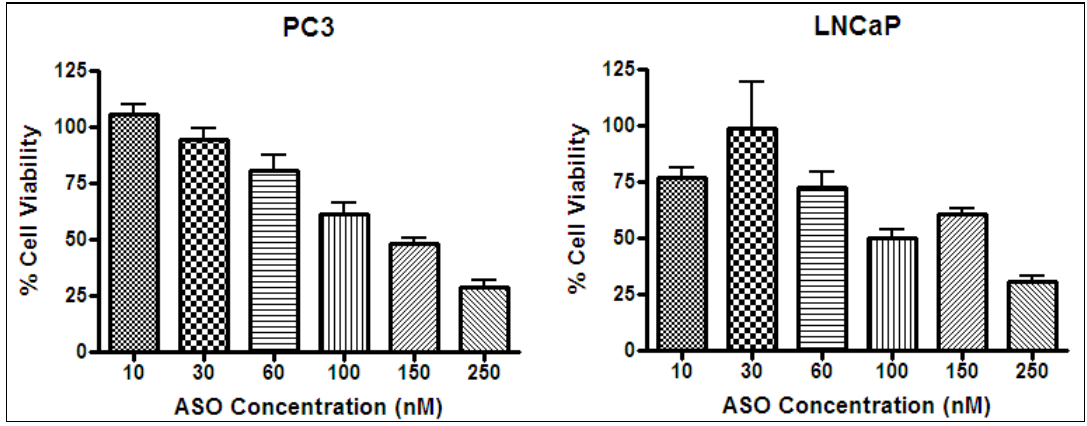
Figure 9. Antisense oligonucleotides (ASO) concentration test on PC3 ( left ) and LNCaP ( right ) at 37 °C. Cell viability by MTS assay.